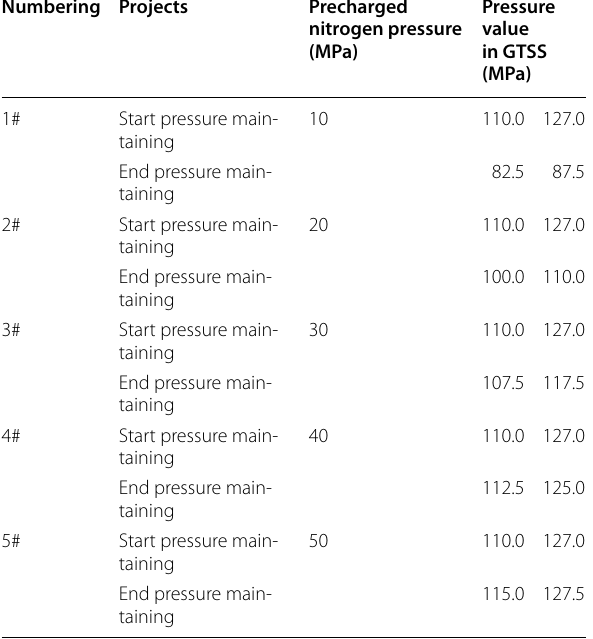
Table 3 Air tightness test results of